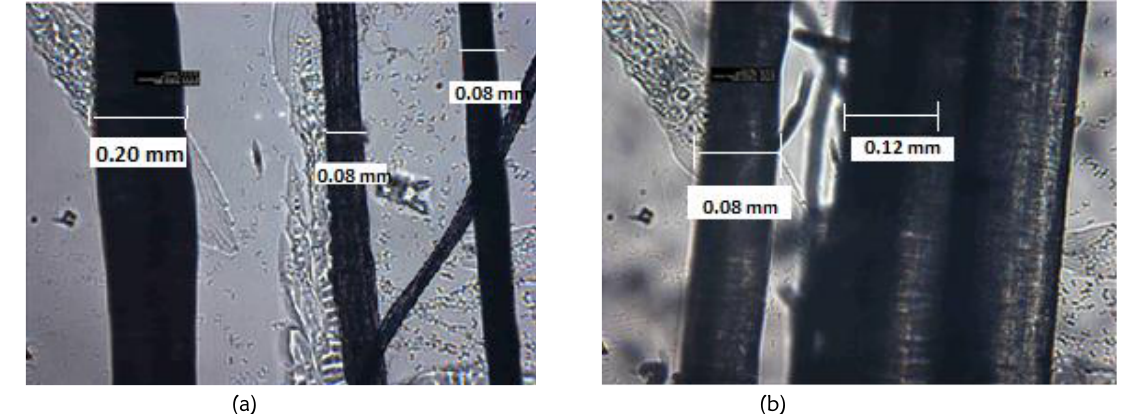
Figure 15: (a), (b) Microscopic view of fibers with the measurement of